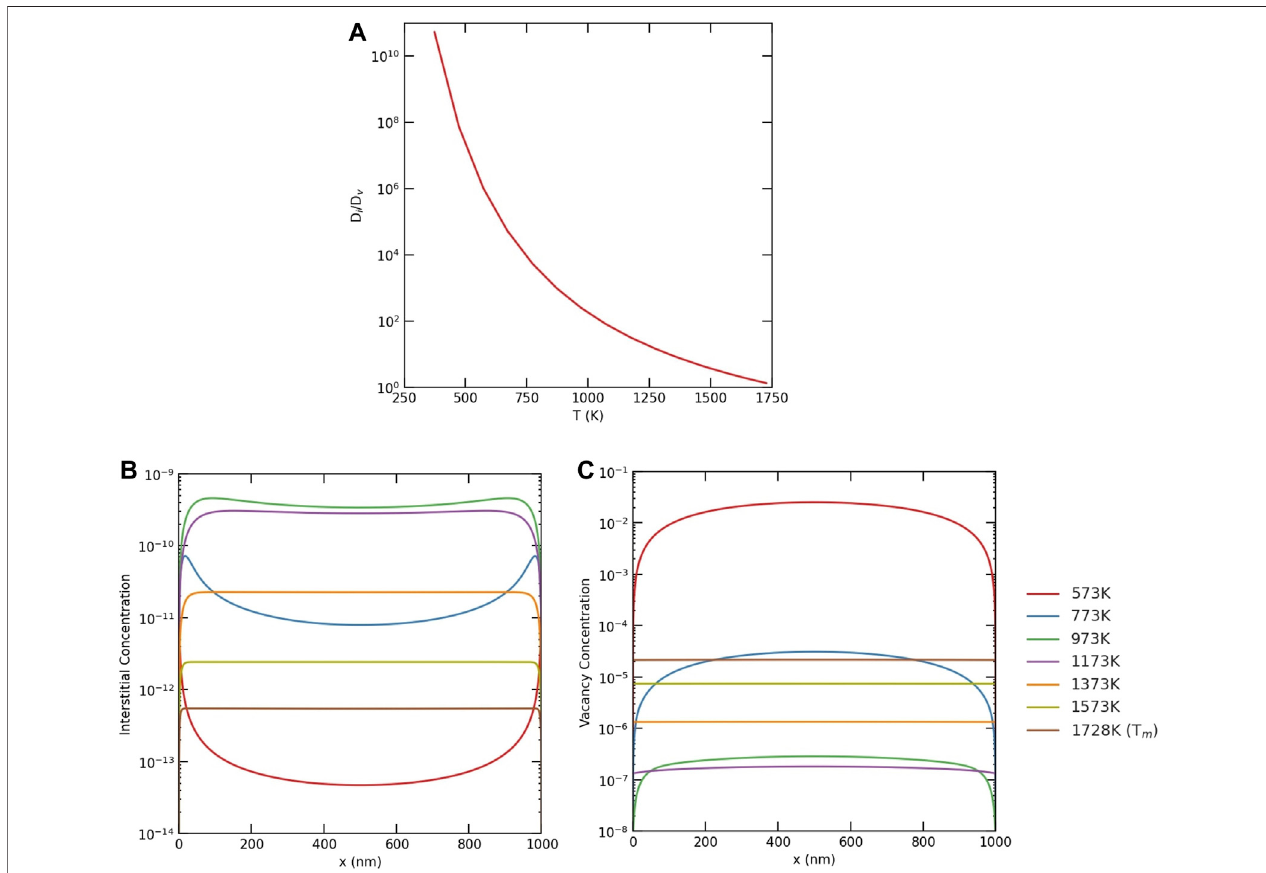
FIGURE4 |(A) The change ofdiffusivity ratio, D i / D v ,with temperature.Effectoftemperature/diffusivity ratioonthe developmentofthe instability at 1e-3 dpa/s and 5% production bias in a 1,000 nm slab/equiaxed grain, (B) for interstitials, (C) for